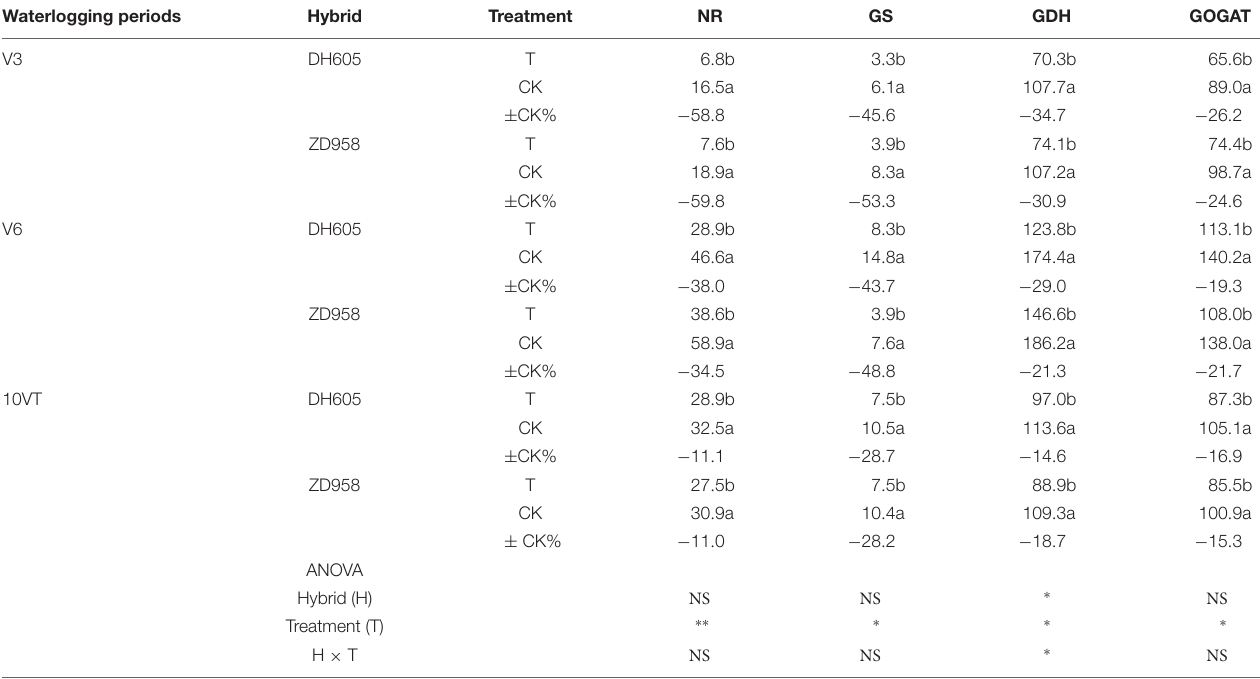
TABLE 2 | Effect of waterlogging on NR ( µ g g − 1 FM h − 1 ), GS ( µ mol GHA g − 1 FM h − 1 ), GDH ( µ mol NADH g − 1 FM min − 1 ), GOGAT ( µ mol NADH g − 1 FM min − 1 ) activities of maize